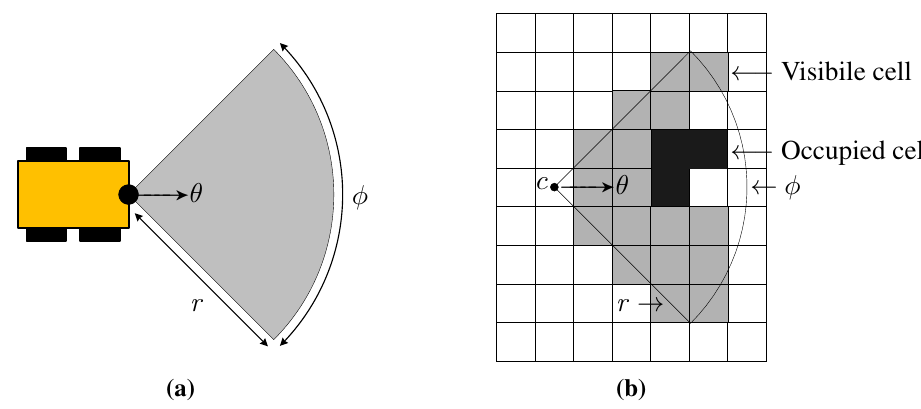
Figure 3. ( a ) a candidate sensing configuration c allows the robot to scan a circular sector of ( c ) is the visibility function which defines which are the central angle φ and radius r ; ( b ) v P cell that are observable from candidate sensing configuration c